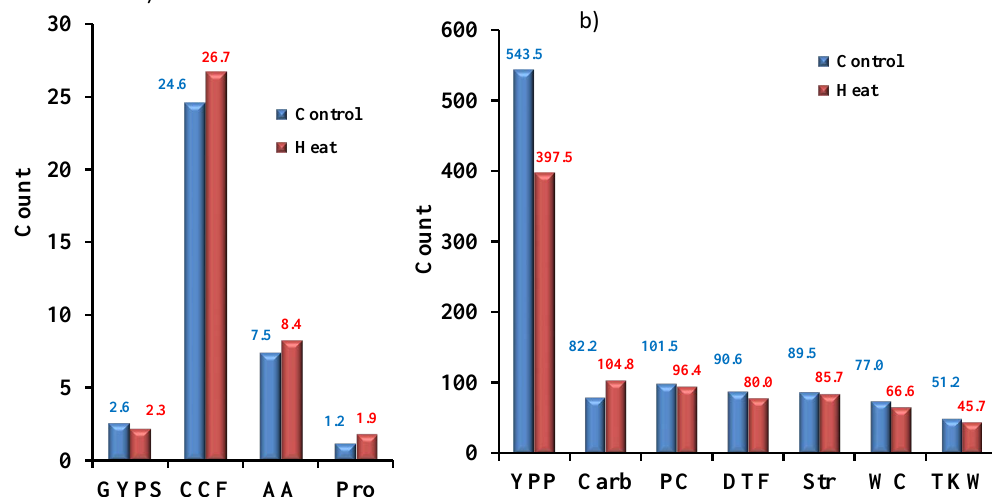
Figure 1: The distribution of the grain yield per spike (GYPS) under control and heat stress during pre-anthesis in barley.